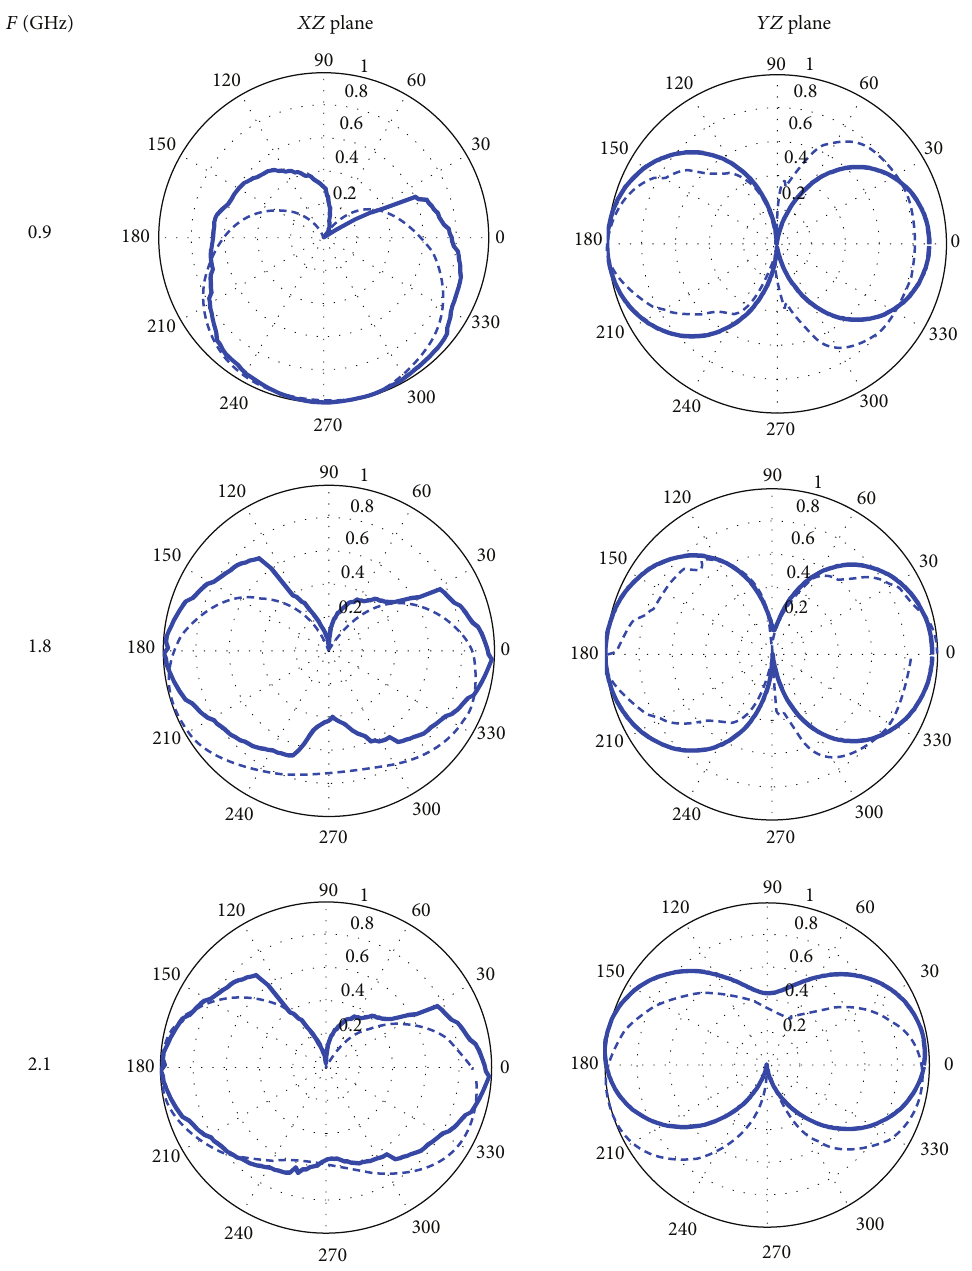
Figure 5: The radiation pattern in the XZ and YZ planes. The antenna is in the XY plane: simulated (solid line); measured (dash line).